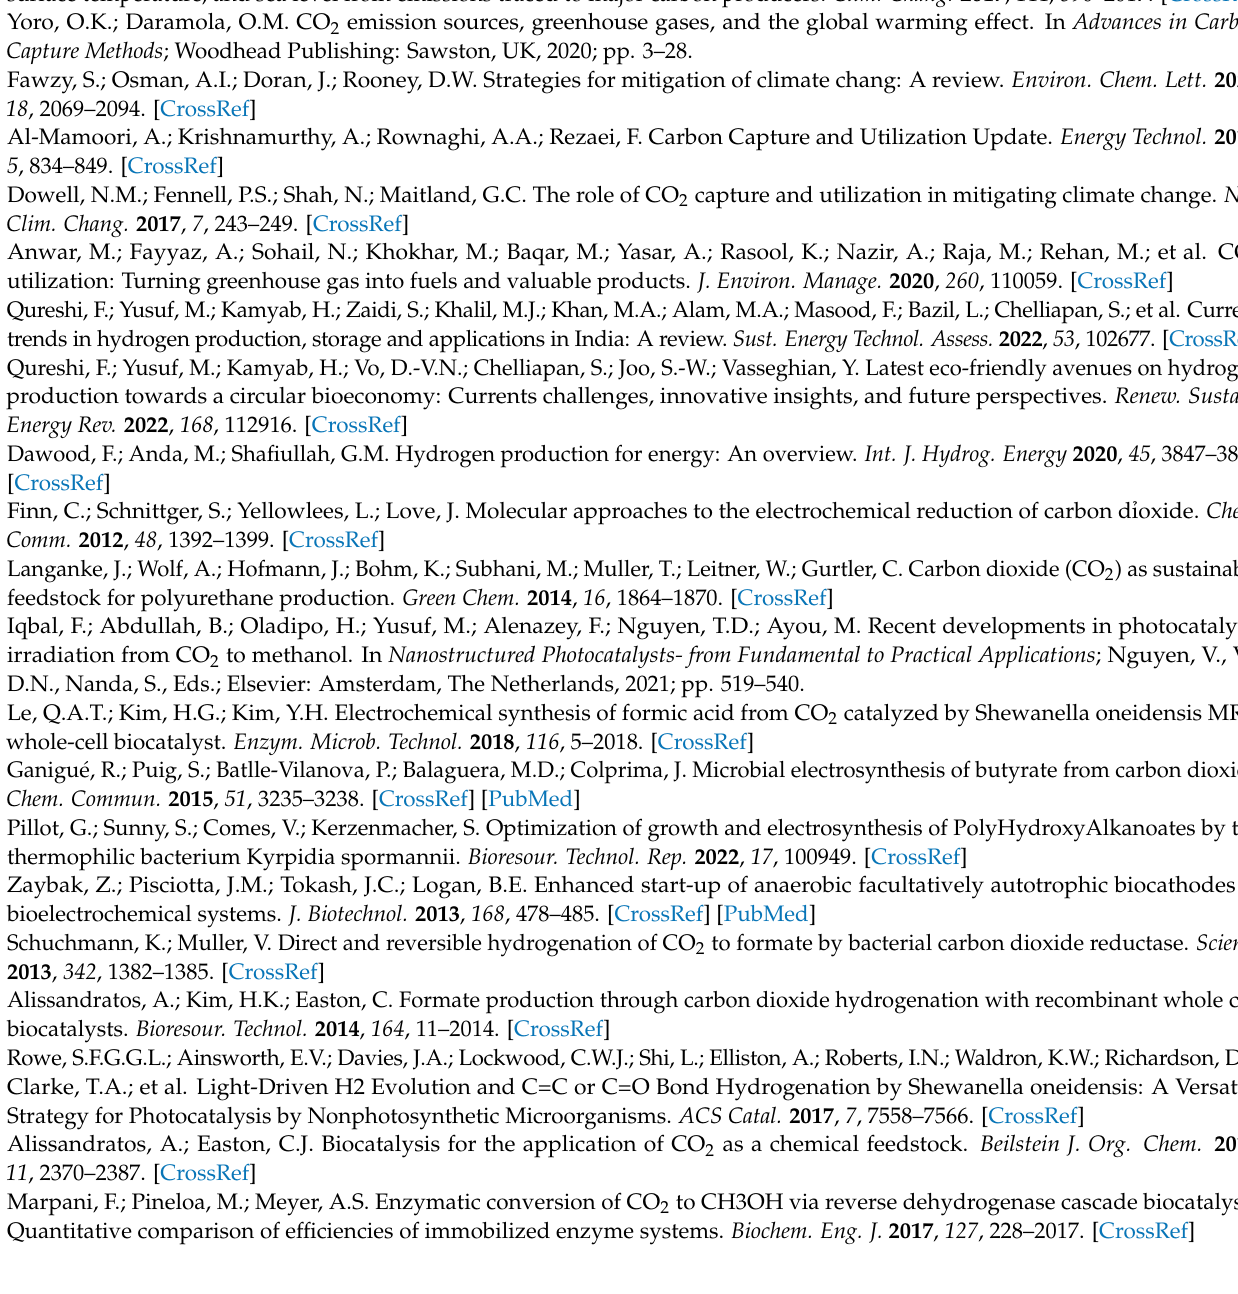
Figure S6: Protein sequence alignment of MtrC from S. oneidensis MR1 (Genbank Accession no. AAN54831.1), S. glacialipiscicola (Genbank accession no. WP_220772613.1), S.algae (Genbank accession no. WP_234523060.1), S. litoralis (Genbank accession no. WP_160053382.1), S. woodyi